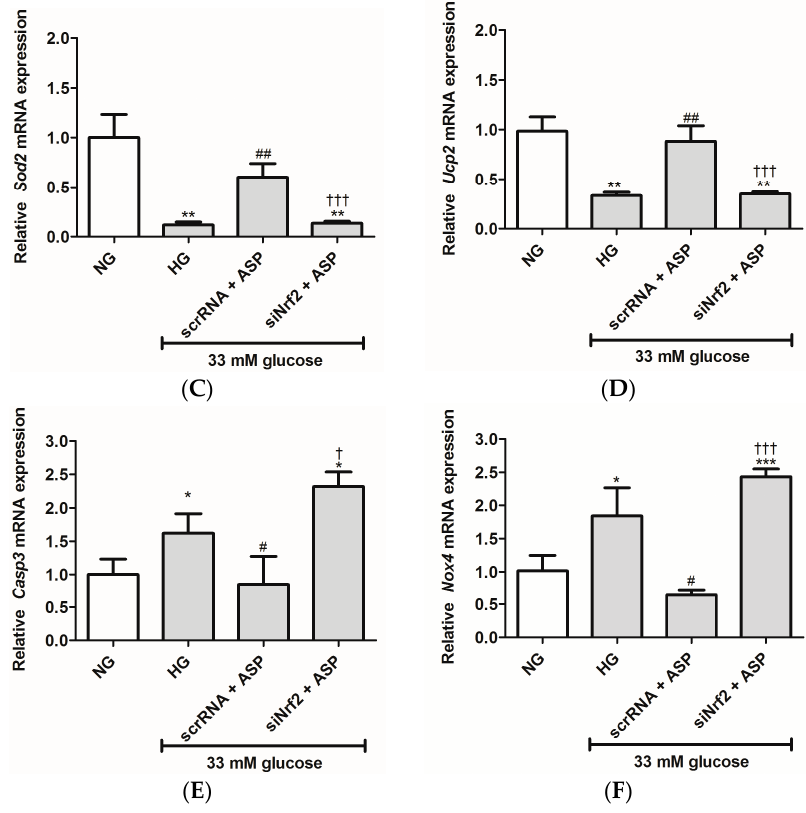
Figure 2. siNrf2 inhibited the effect of aspalathin (ASP) in vitro. The relative mRNA expression of antioxidant genes, including ( A ) Gpx2 , ( B ) Park7 , ( C ) Sod2 , and ( D ) Ucp2 , and oxidative damage associated genes ( E ) Casp3 and ( F ) Nox4 after transfection of cells with either small interfering RNA (siNrf2) or scrambled RNA (scrRNA) for 24 h followed by treatment with 1 µM ASP for 6 h. Results are expressed as the mean ± SEM of 3 independent biological experiments relative to the normal glucose (NG) control, each done in triplicate. * p ≤ 0.05, ** p ≤ 0.001, *** p ≤ 0.0001 vs. NG, # p ≤ 0.05, ## p ≤ 0.001 vs. HG, † p ≤ 0.05, ††† p ≤ 0.0001 vs. scrRNA + ASP.